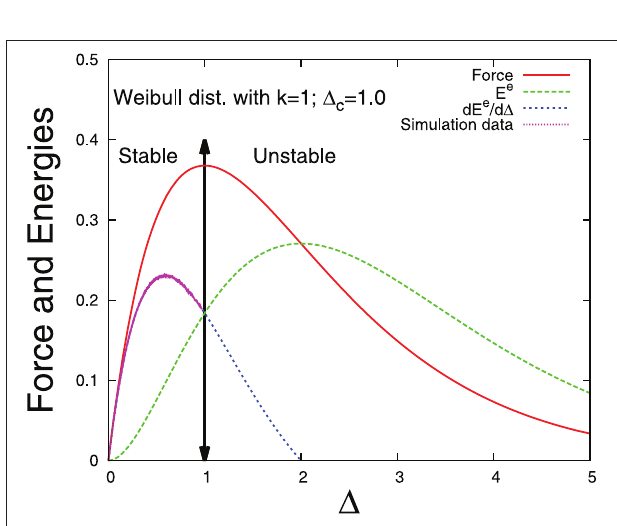
FIGURE 8 | Force and elastic energies vs. extension 1 for fiber bundles with Weibull distribution of thresholds: Comparison with simulation data for a single bundle with N 10 7 =